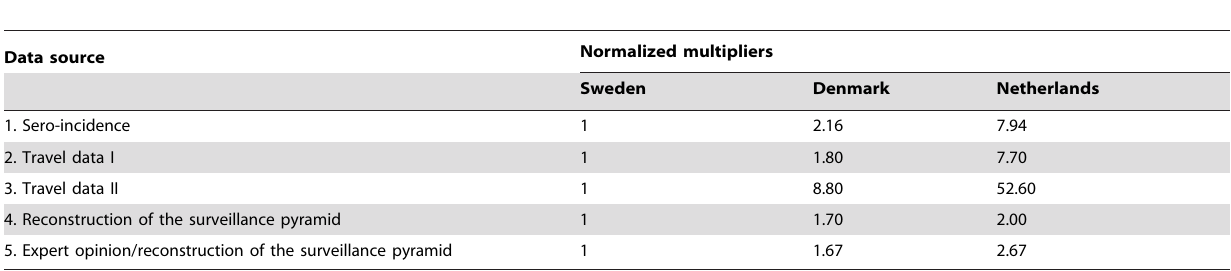
Table 5. Normalized multipliers, i.e. the multipliers for Sweden, Denmark and The Netherlands from the five different data sources, divided by the multipliers for